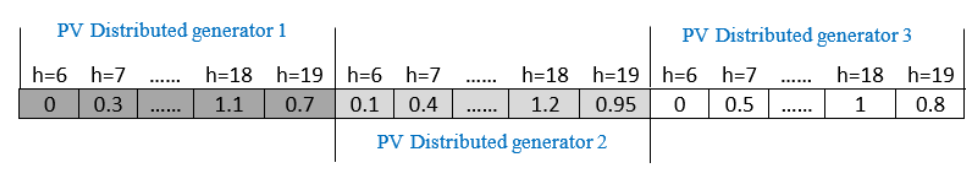
Figure 1. Codification used for solving the problem of optimal operation of PV DGs in DC